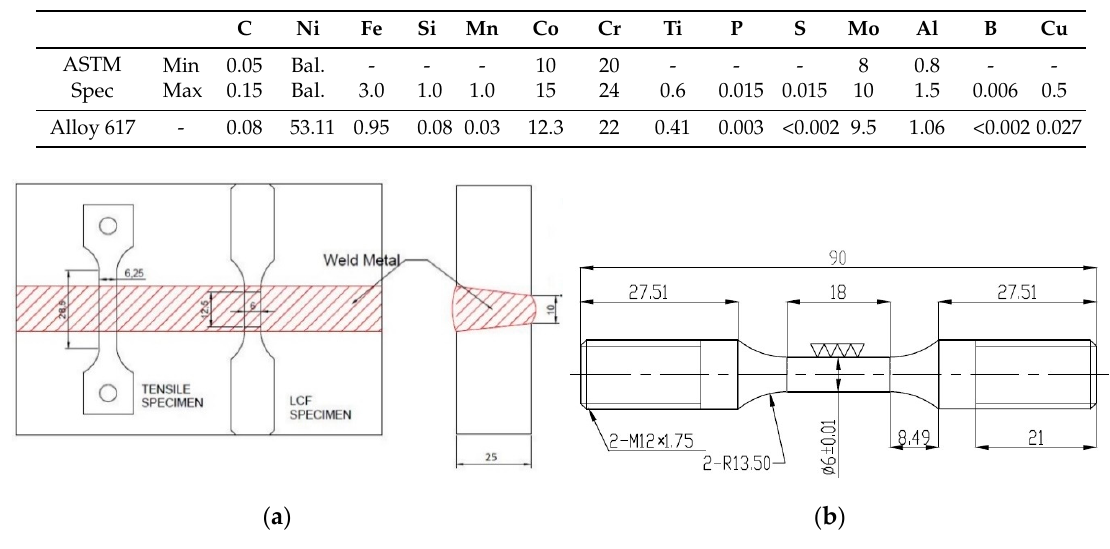
Figure 1. Microstructure of the cross ‐ view for Alloy 617 weldments. Table 1. The chemical composition of Alloy 617 plate (wt. %).